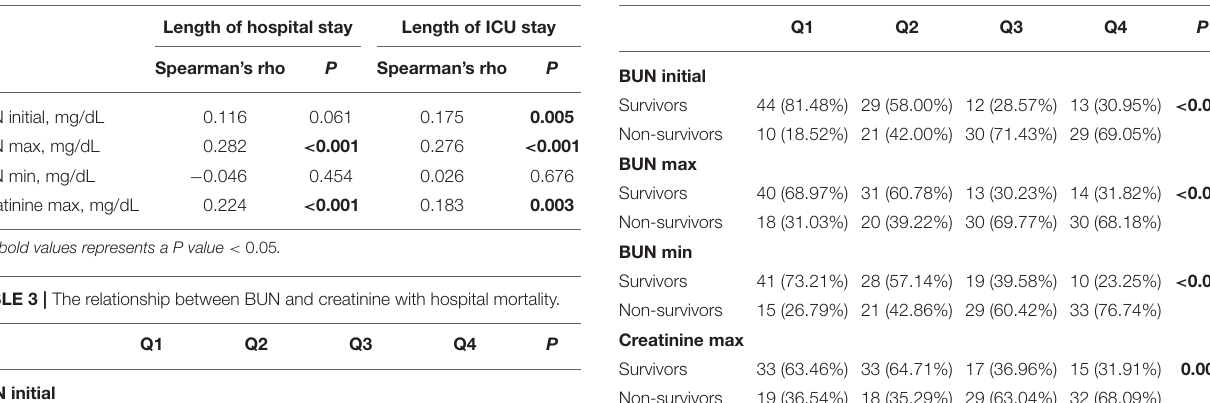
TABLE 5 | The relationship between BUN and creatinine with 4-year